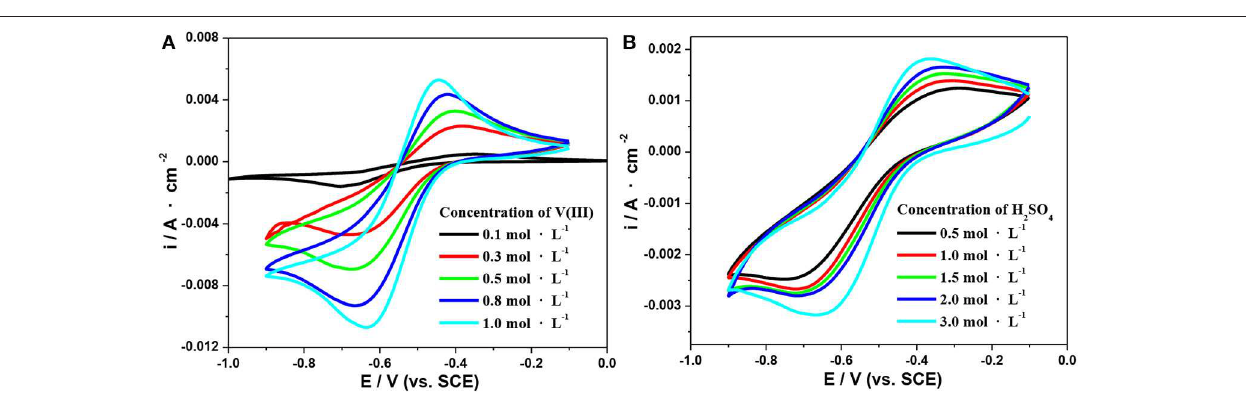
FIGURE 4 | CV curves on an SPGR in 2.0 mol · L − 1 H 2 SO 4 with different concentrations of V(III) (A) and 0.1 mol · L − 1 V(III) with different concentrations of H 2 SO 4 (B) . Scan rate, 10 mV · s − 1 .